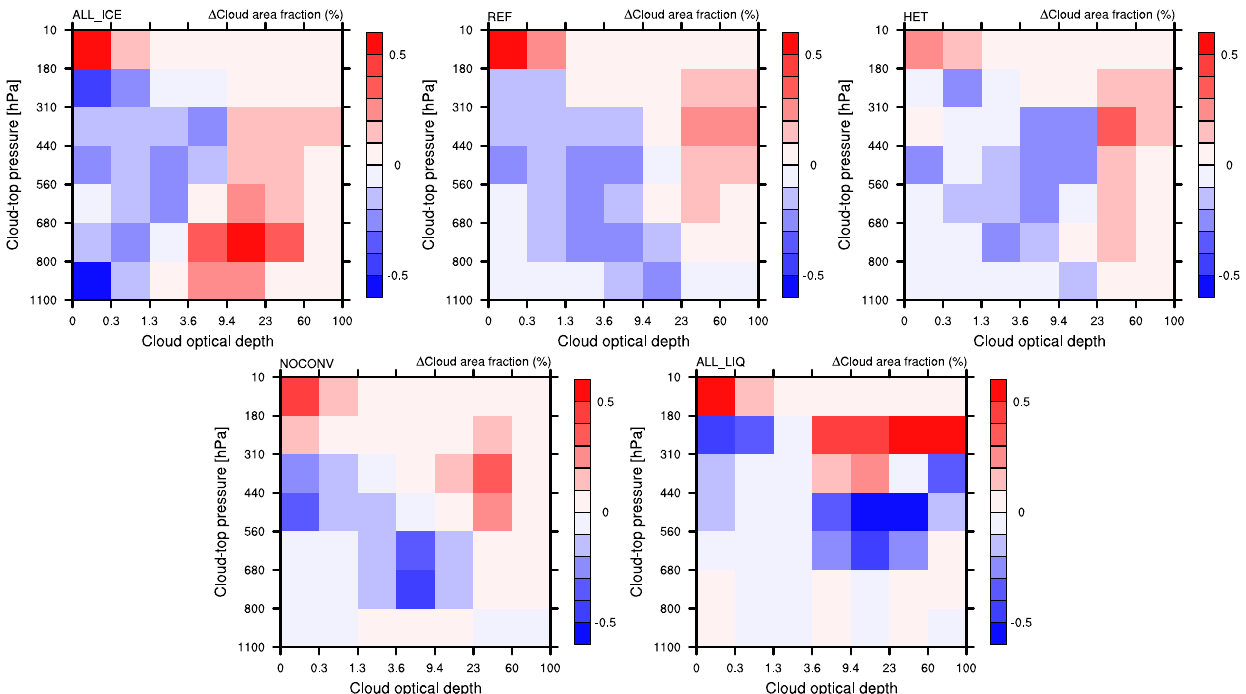
Figure 5. Changes in the distribution of cloud fraction in the extratropics ( > 40 ◦ S and N) as a function of cloud optical depth and cloud-top pressure between the 2 × CO 2 and the 1 × CO 2 climates in simulations ALL_ICE, HET, REF, NOCONV, and ALL_LIQ from the last 25 years of the MLO simulations described in Table 1.